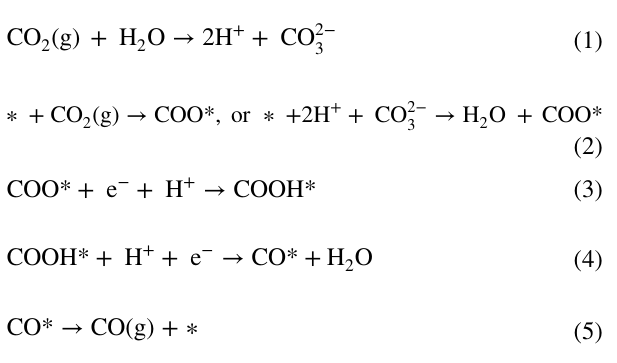
To rationalize such remarkably enhanced catalyzing prop- erties of the ICN-3 over the pristine g-C